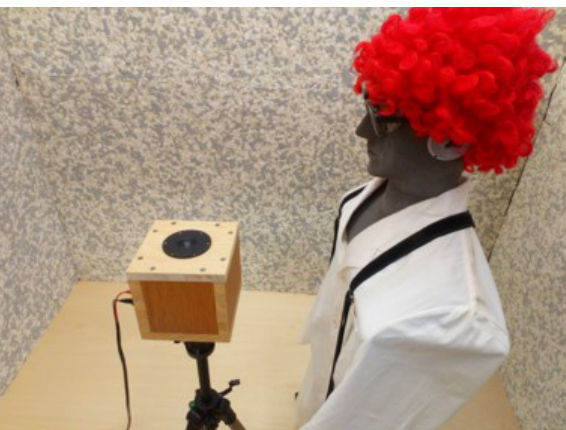
Figure 5. Experimental setup used for the simulation of an idealized sound field produced by an ultrasonic cleaning bath and a compressed air gun built within the free-field environment at the PTB Braunschweig, Germany.